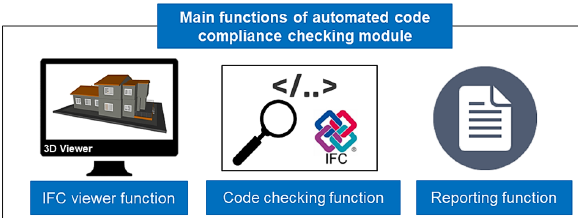
Figure 4. Main functions of the automated code compliance checking module